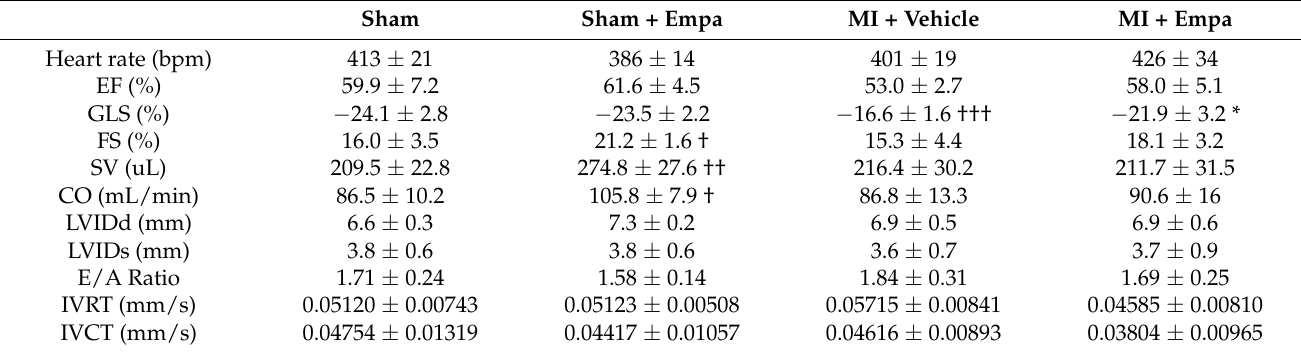
Table 1. Hemodynamic parameters measured 7 days after myocardial infarction via echocardiography. Sham Sham + Empa MI + Vehicle MI +